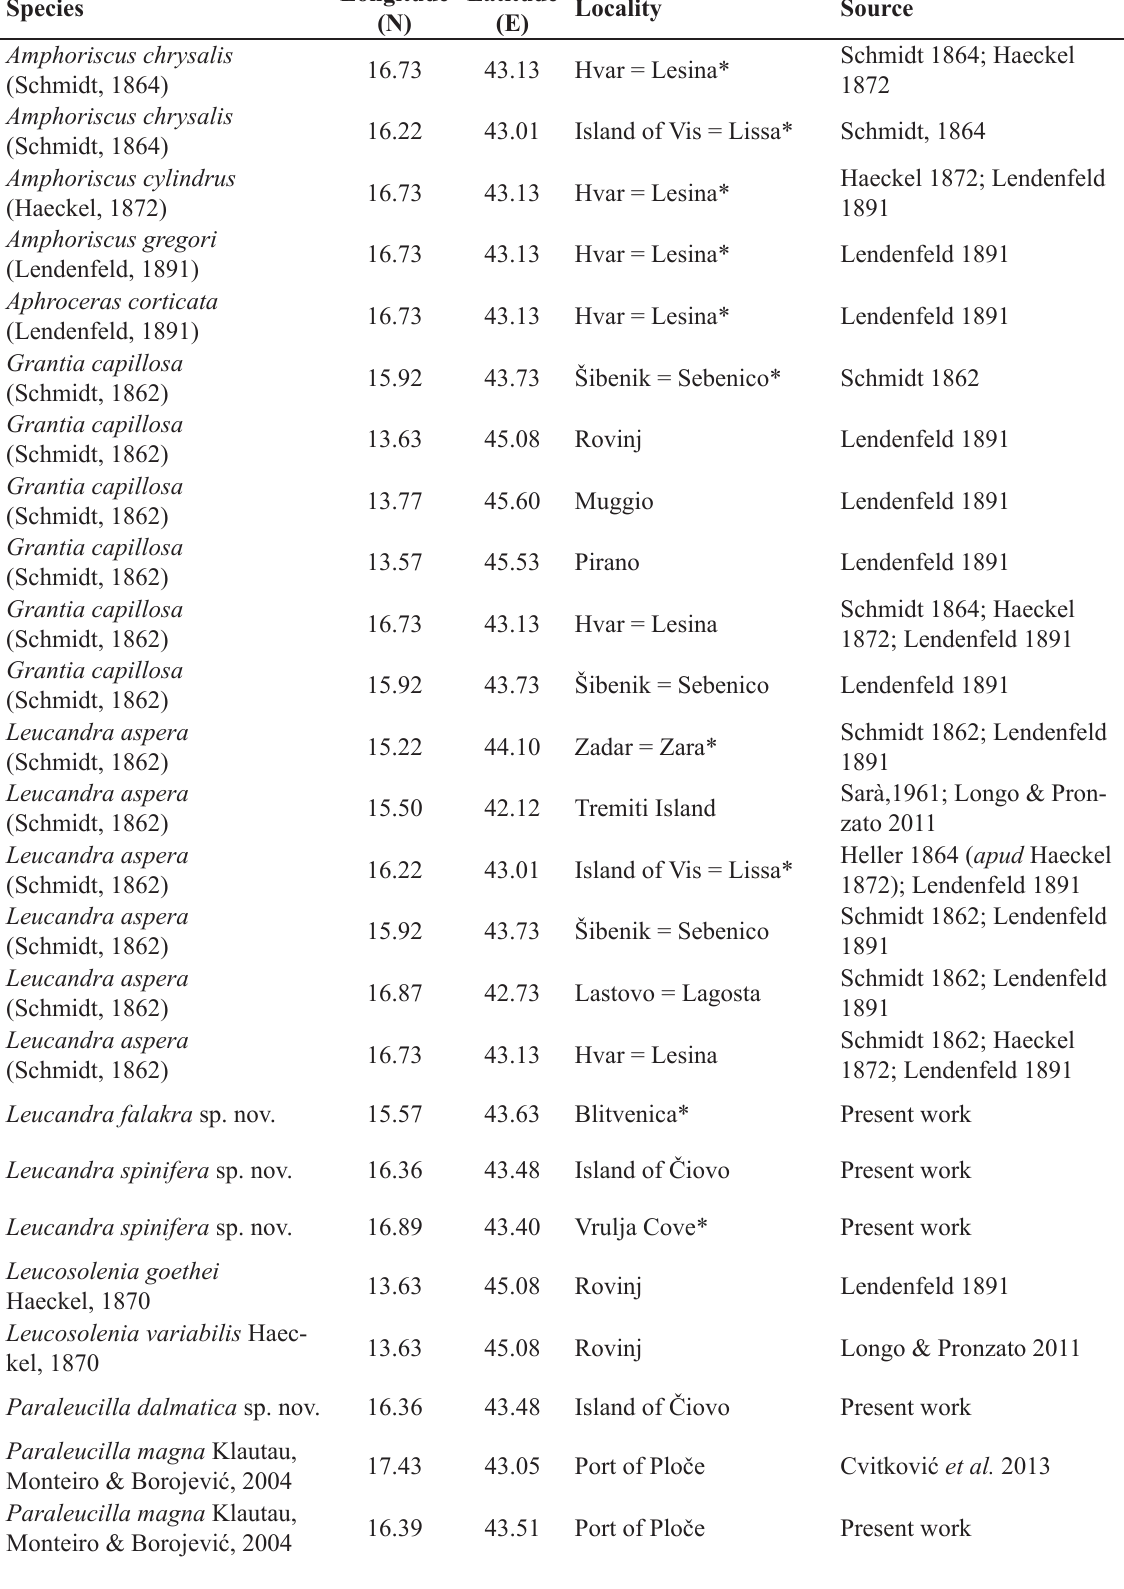
Table 13. Calcaronean species reported from the Adriatic Sea and their distribution. * = Type